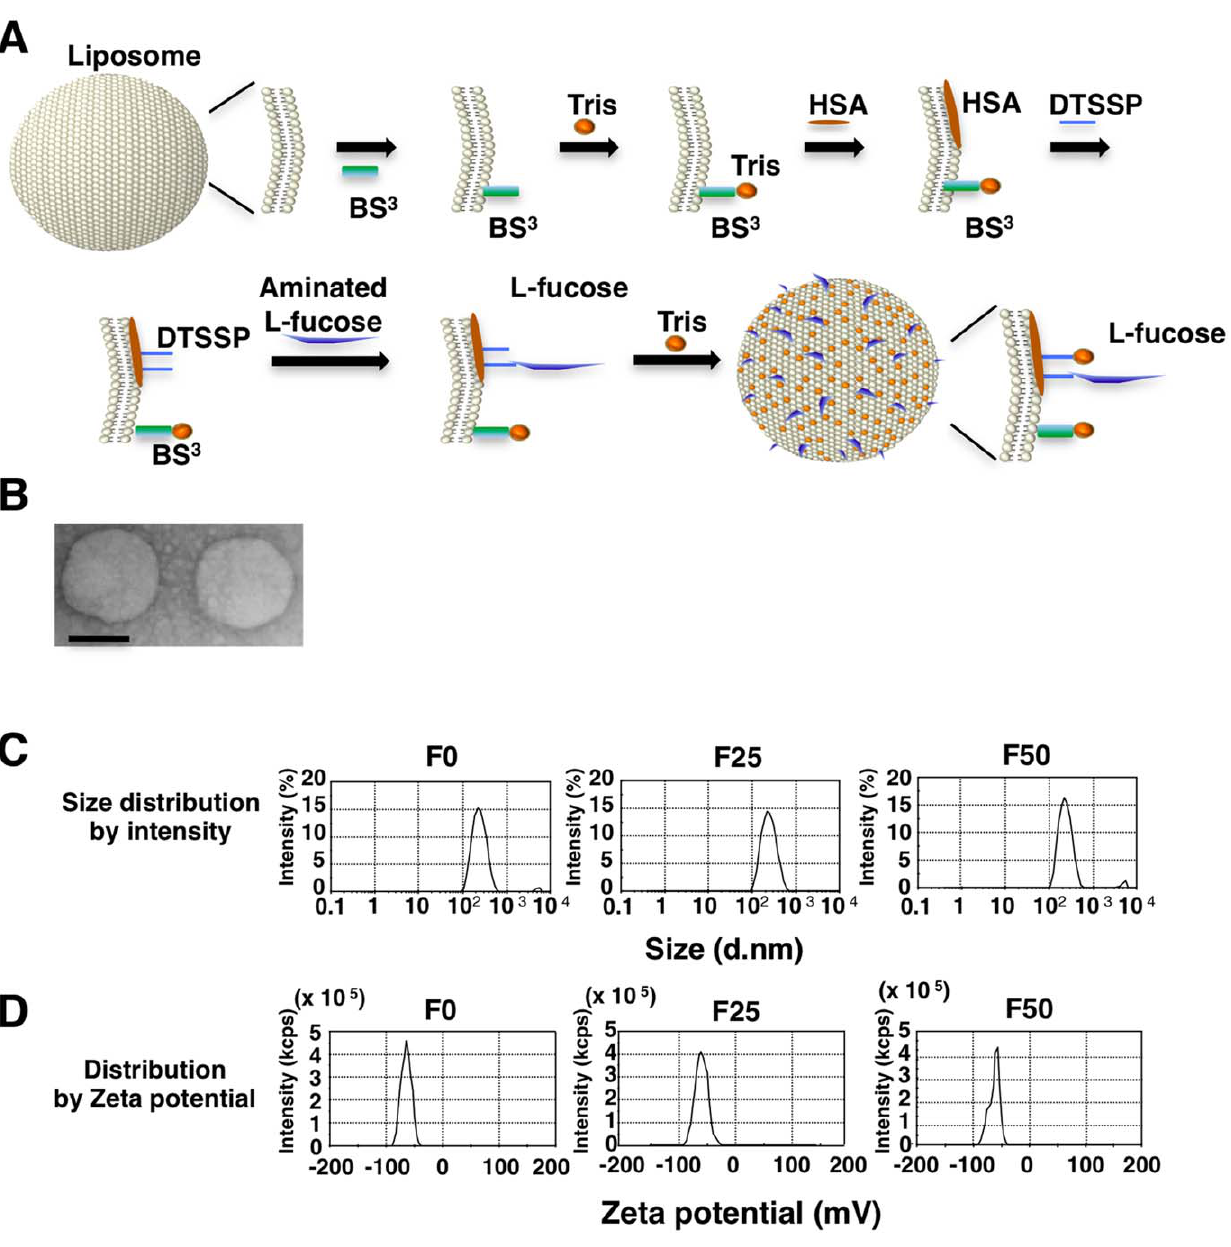
Figure 1. Production and physicochemical properties of L-fucose-bound liposomes. ( A) Liposome preparation scheme showing sugar chains. HSA, BS 3 , Tris, and DTSSP denote the following, respectively: human serum albumin; bis(sulfosuccinimidyl) suberate; Tris(hydroxymethyl) aminomethane; 3,3-dithiobis (sulfosuccinimidylpropionate). ( B) Electron microscopic image of L-fucose-bound liposome. Scale bar shows 50 nm. ( C, D) Physicochemical characterization of Fuc-Liposome-Cy5.5. Average particle size (C) and zeta-potential (D) of liposomes that were prepared in water was determined by dynamic light scattering spectrophotometry.